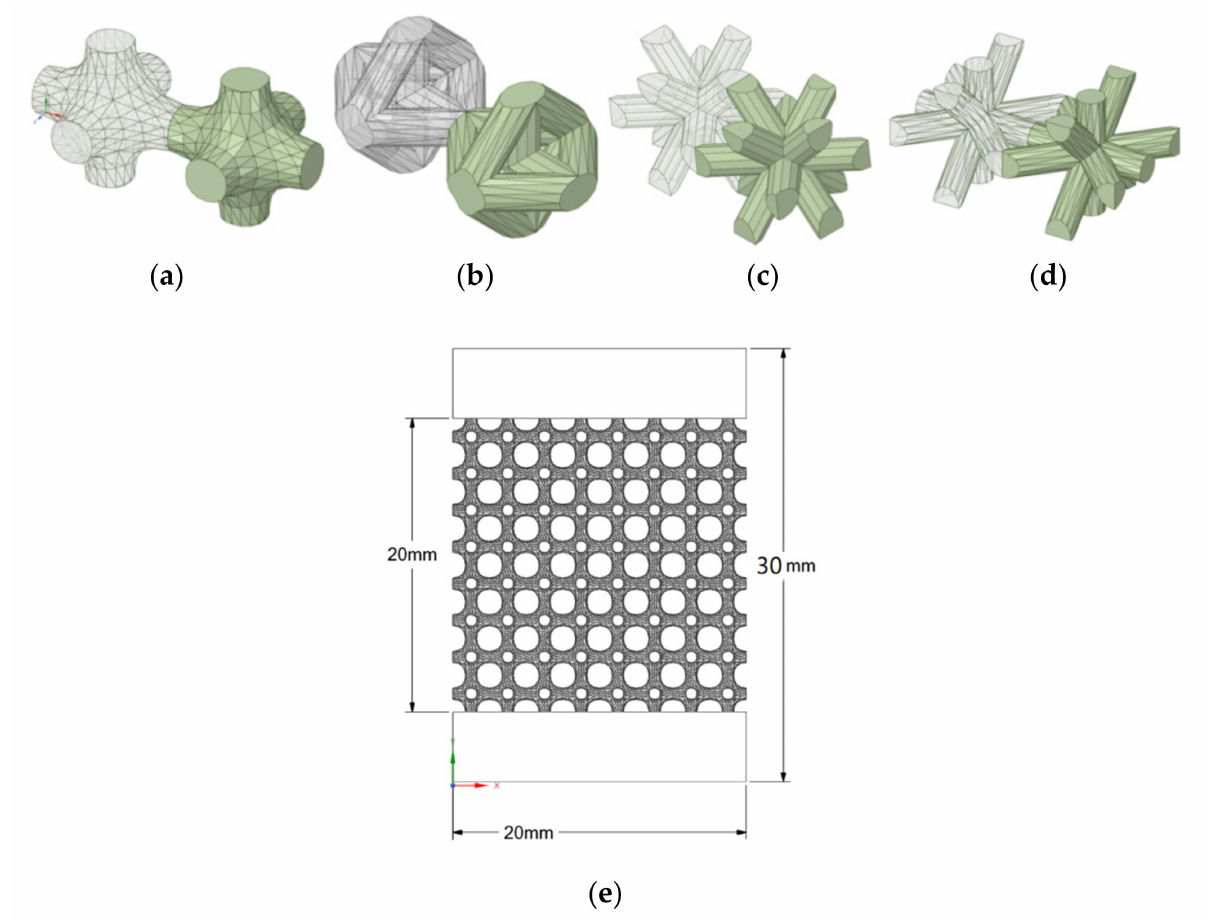
Figure 1. Unit cell design: ( a ) 3D lattice infill pattern, ( b ) double-pyramid lattice with cross, ( c ) double- pyramid lattice and face diagonals, ( d ) octahedral lattice 2, ( e ) specimens’ dimensions.